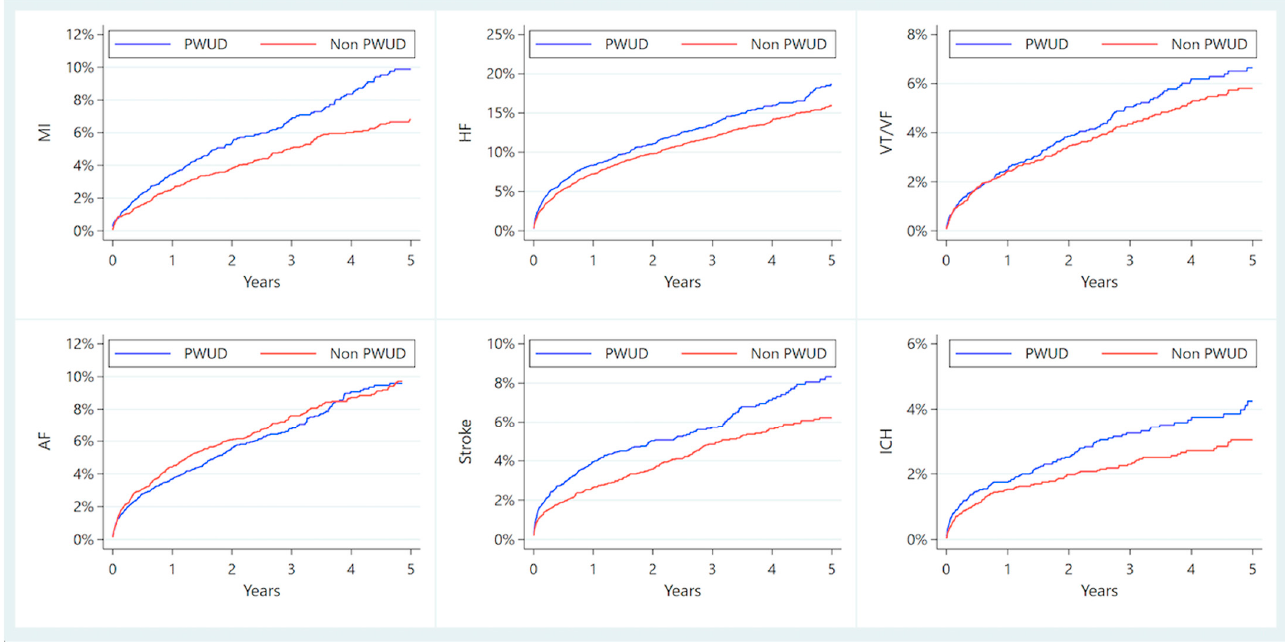
Figure 2. Five ‐ year cumulative incidence of cardiovascular and cerebrovascular events after a first episode of infective endocarditis in people who use drugs (PWUD) vs. non ‐ PWUD patients. We excluded patients who had recorded history of each outcome of interest at baseline, respectively (i.e., those with known AF were excluded from AF analysis) to only capture new ‐ onset events. AF: atrial fibrillation or flutter; HF: heart failure; ICH: intracranial hemorrhage; MI: myocardial infarction; PWUD: persons who use drugs; VF: ventricular fibrillation; VT: ventricular tachycardia.